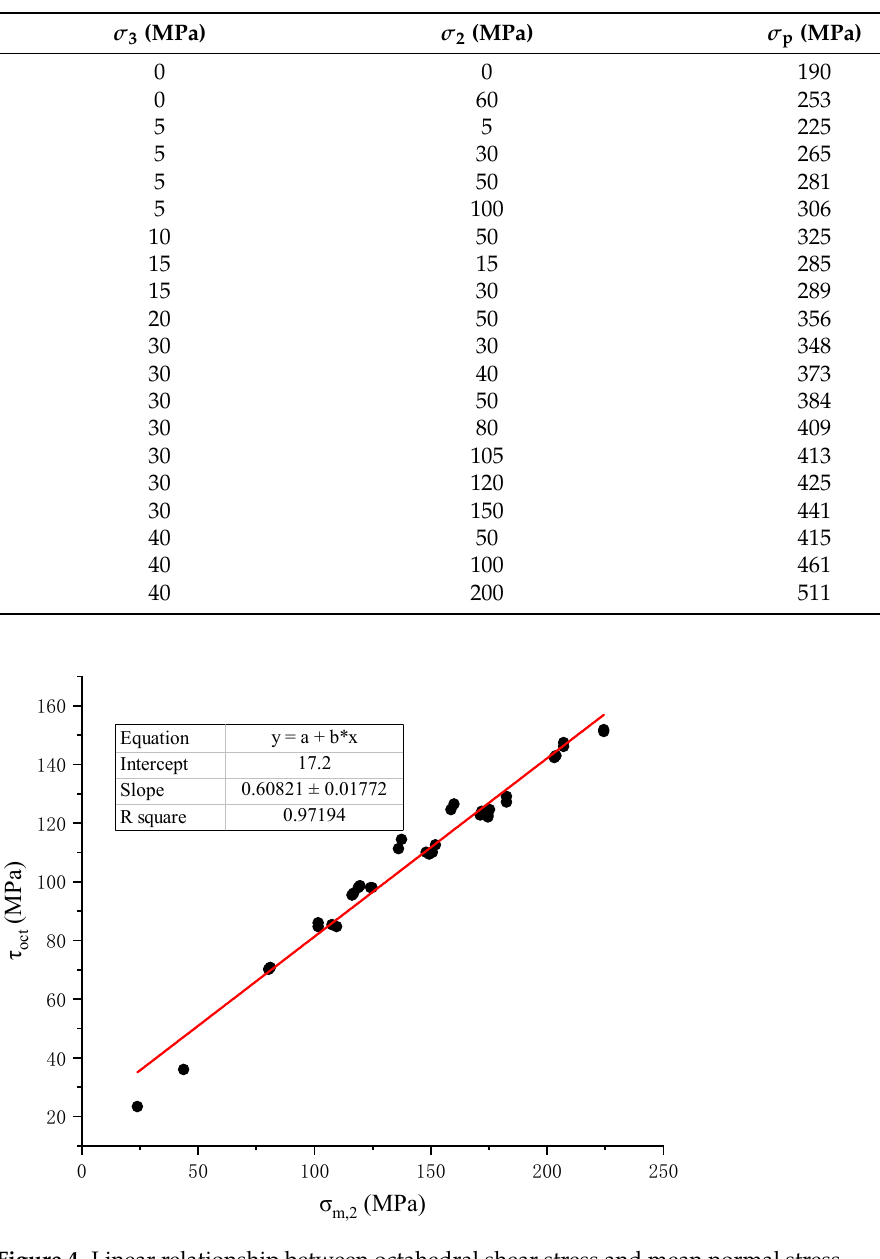
Figure 4. Linear relationship between octahedral shear stress and mean normal stress. The determination of the parameters of the constitutive model under the action of true triaxial stress is consistent with the above process. In the case of three-dimensional stress, this paper selects rock creep test data under different intermediate principal stresses and rock creep data under different maximum principal stresses, respectively, for verification. The creep parameters of marble under the true triaxial stress state were obtained as shown in Table 3. The experiments conducted by Zhao did not consider the chemical damage of the rock. Therefore, for the rock creep equation derived in this paper considering chemical damage, the chemical damage factor D c is 0. Combined with the yield surface constants C 1 , C 2 obtained above and the determined parameters of the constitutive model, the comparison between the test curve and the model curve of the rock under the action of true triaxial stress is shown in Figure